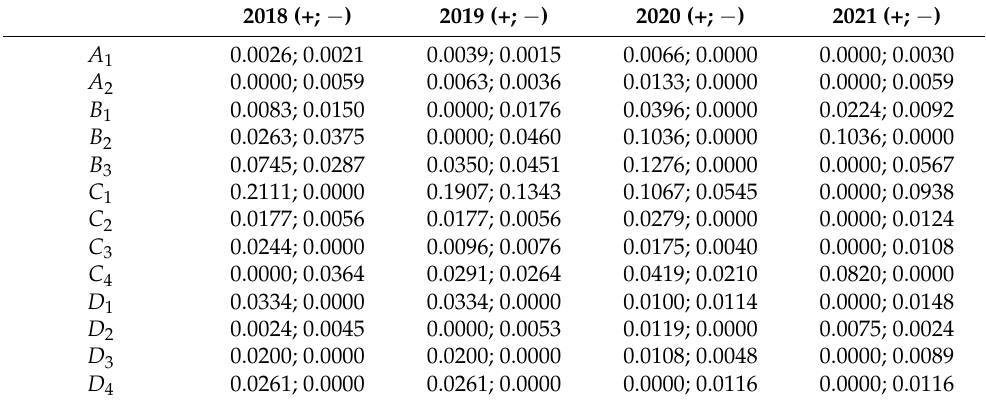
Table 20. Distance of corresponding indicators from positive and negative ideal solutions during 2018–2021. 2018 (+; −